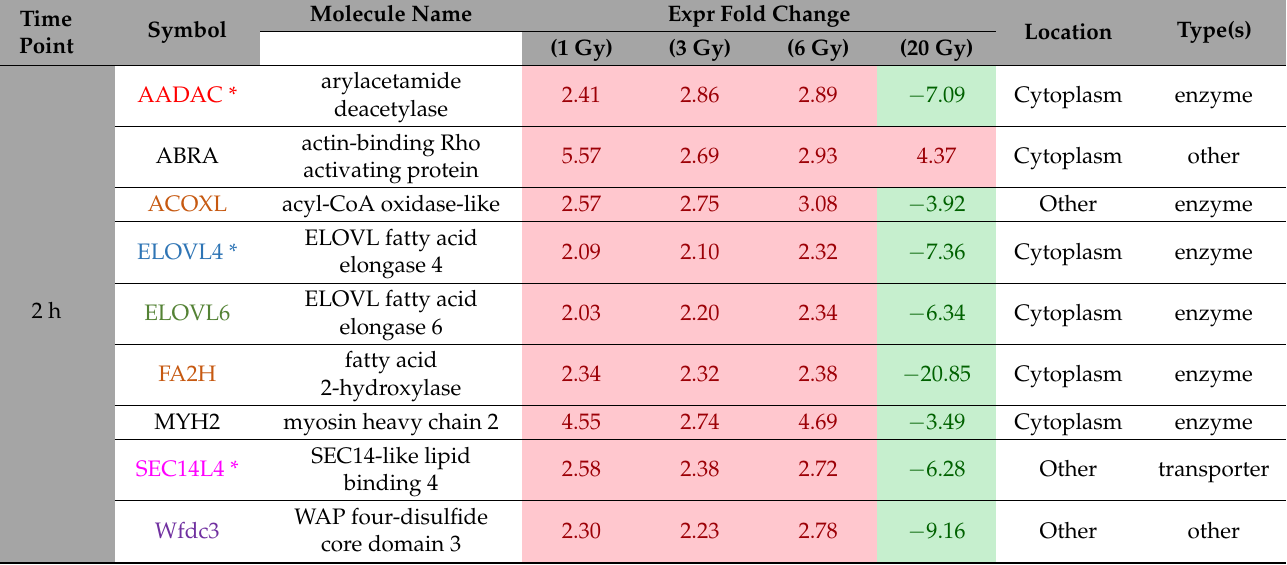
Table 5. List of SDTGs ( p < 0.05, FC ≥ 2 and average > 3 FC) common to all IR doses at each time